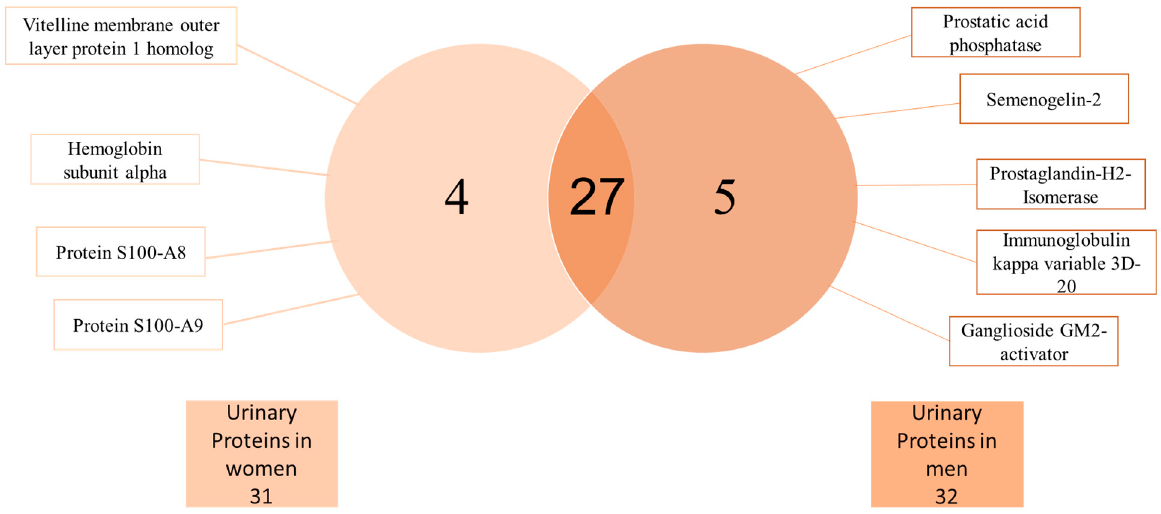
Figure 4. Basic Venn diagram. A total of 36 urine proteins were identified by LC-MS/MS analysis. Four proteins were only found in women and five only in men, whereas 27 proteins were found in both genders.